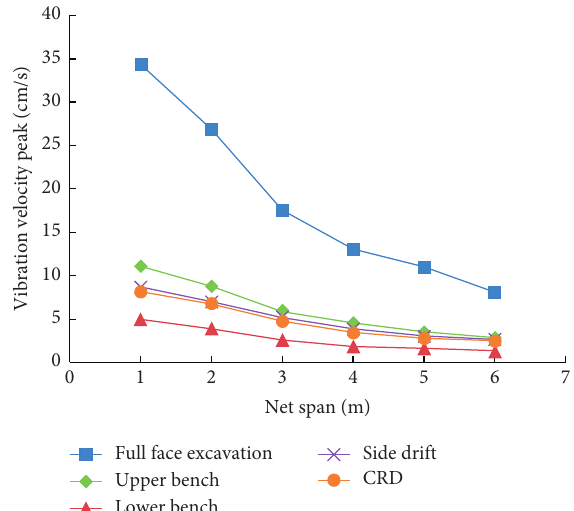
Figure 8: Variation curves of vibration velocity peak with net span under different excavation methods.